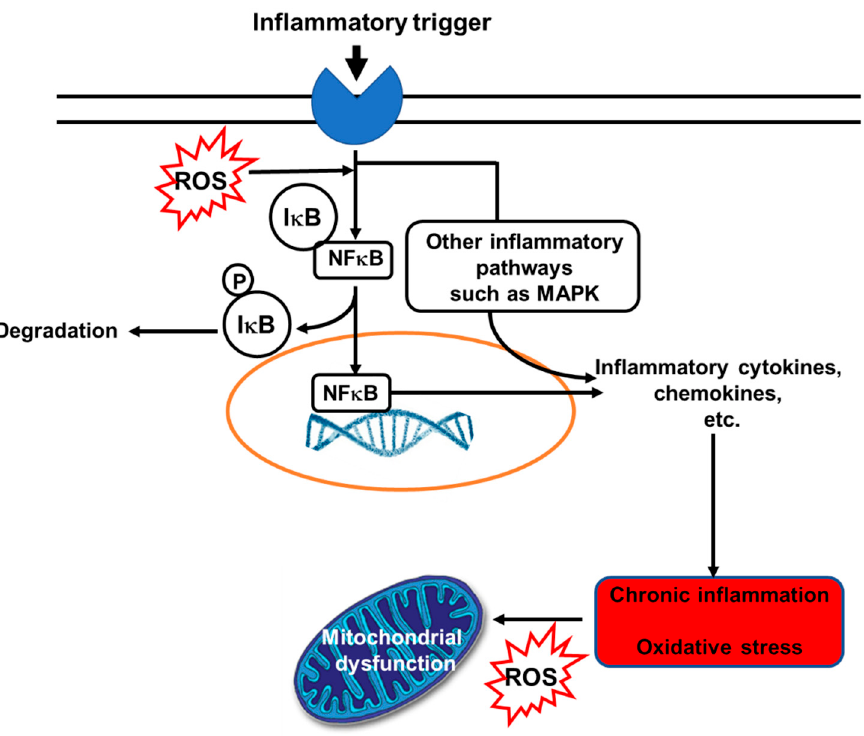
Figure 1. The bidirectional links between inflammation and oxidative stress. Reactive oxygen species (ROS) can act as inflammatory trigger initiating inflammation. On the other hand, inflammation induces oxidative stress. Abbreviations used: IkB, inhibitory subunit of NFkB; MAPK, mitogen-activated protein kinase; NFkB, nuclear factor kappa-light-chain-enhancer of activated B cells; P, phosphate; ROS, reactive oxygen species. Reproduced from [7].